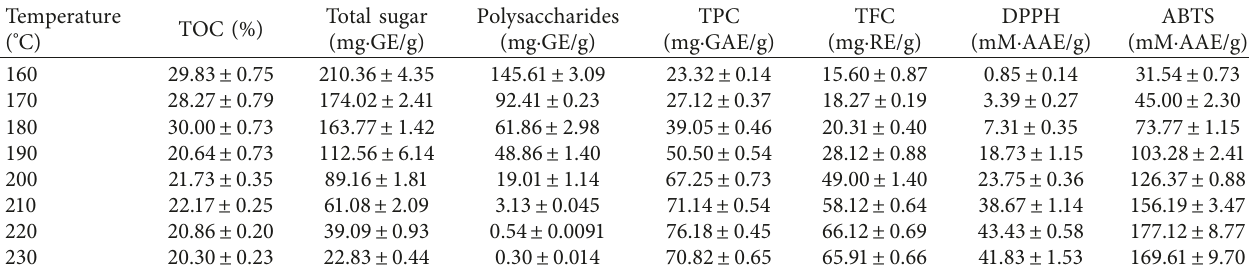
Table 1: Chemical constituents and antioxidant activities of different okara extracts by using SWE.